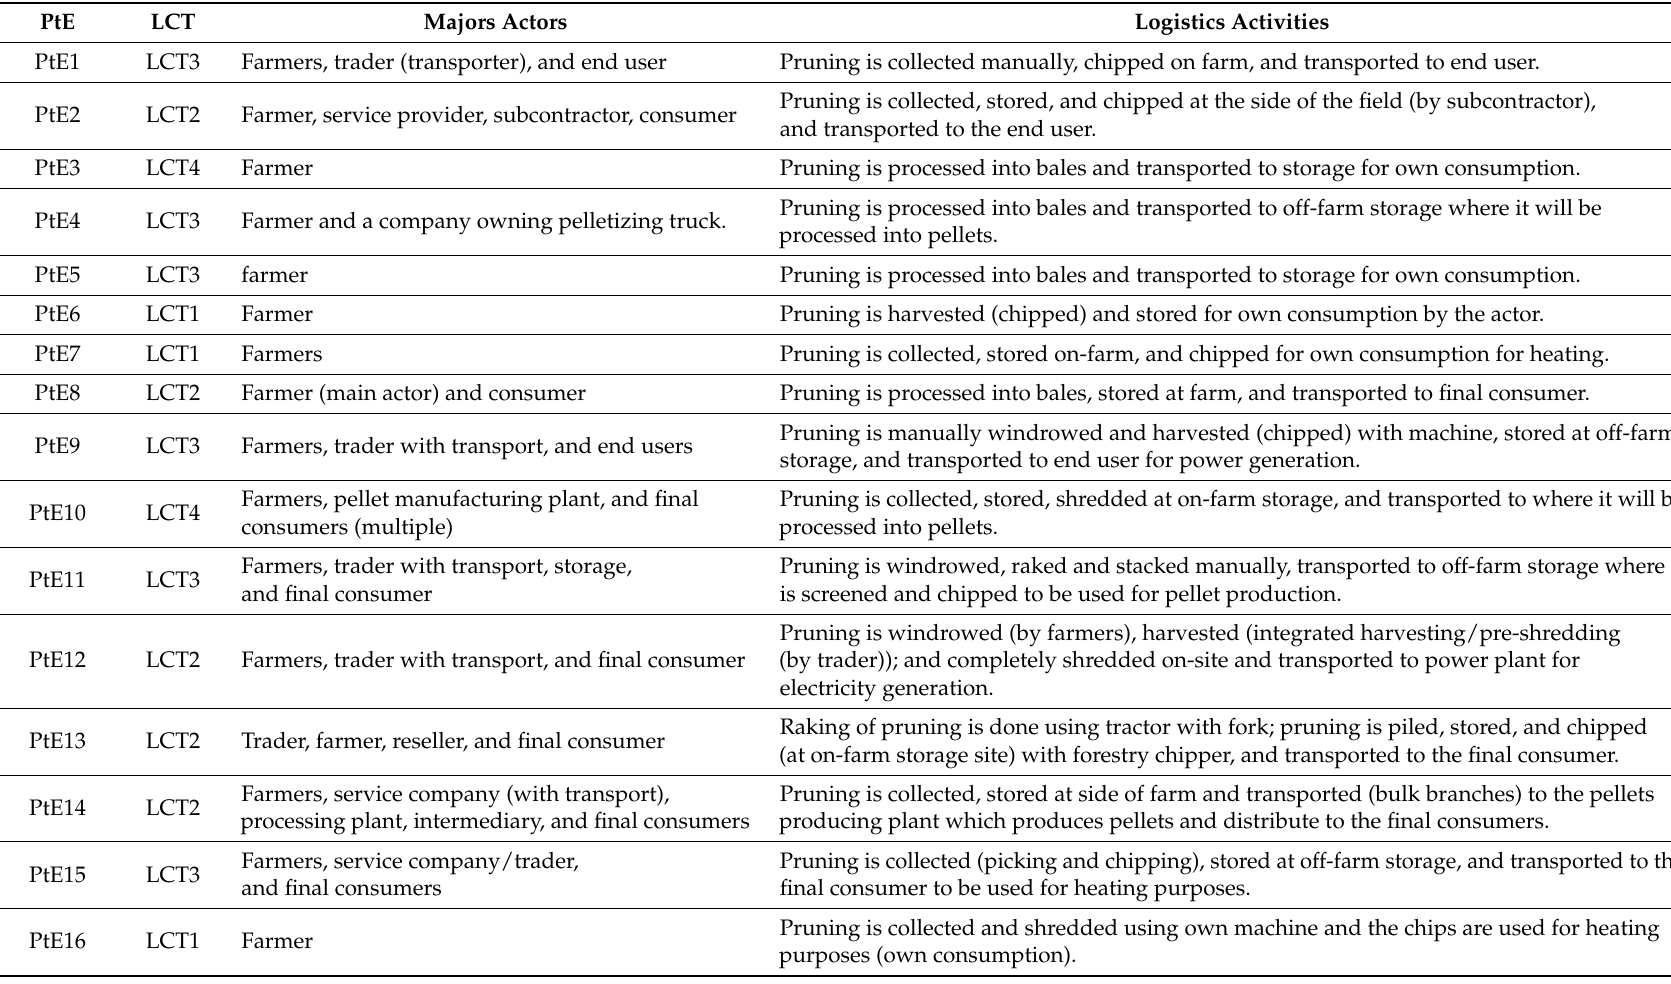
Table 3. Main actors and logistics activities in the 25 PtE value chains investigated in this